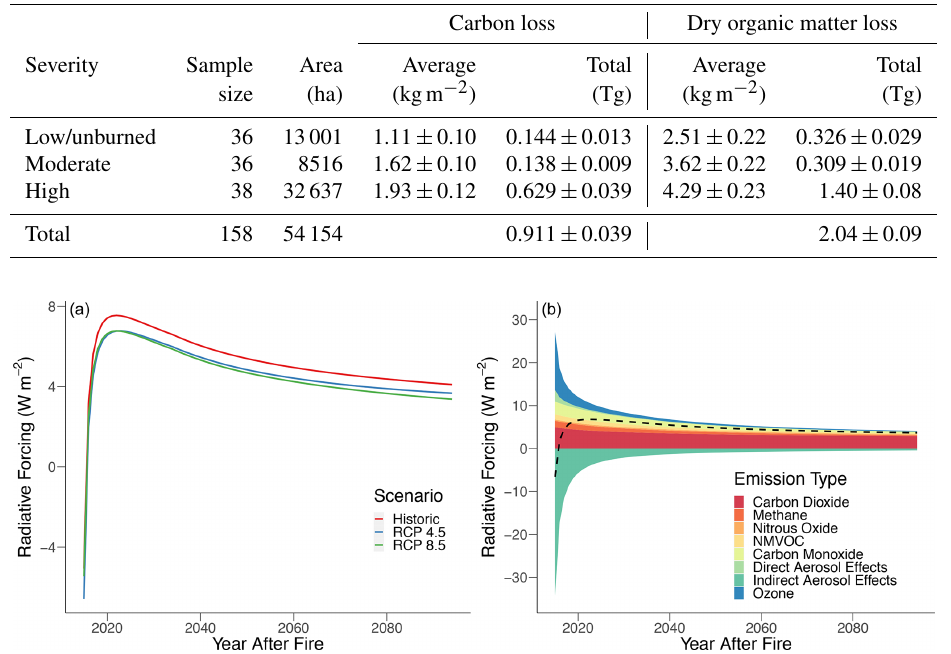
Figure 4. (a) Total cumulative mean radiative forcing of gaseous emissions for three future atmospheric gas concentration scenarios and (b) cumulative mean radiative forcing of different emissions (dashed line is net forcing) under the RCP 4.5 future scenario over 80 years post-fire from the YKD 2015 fire season.